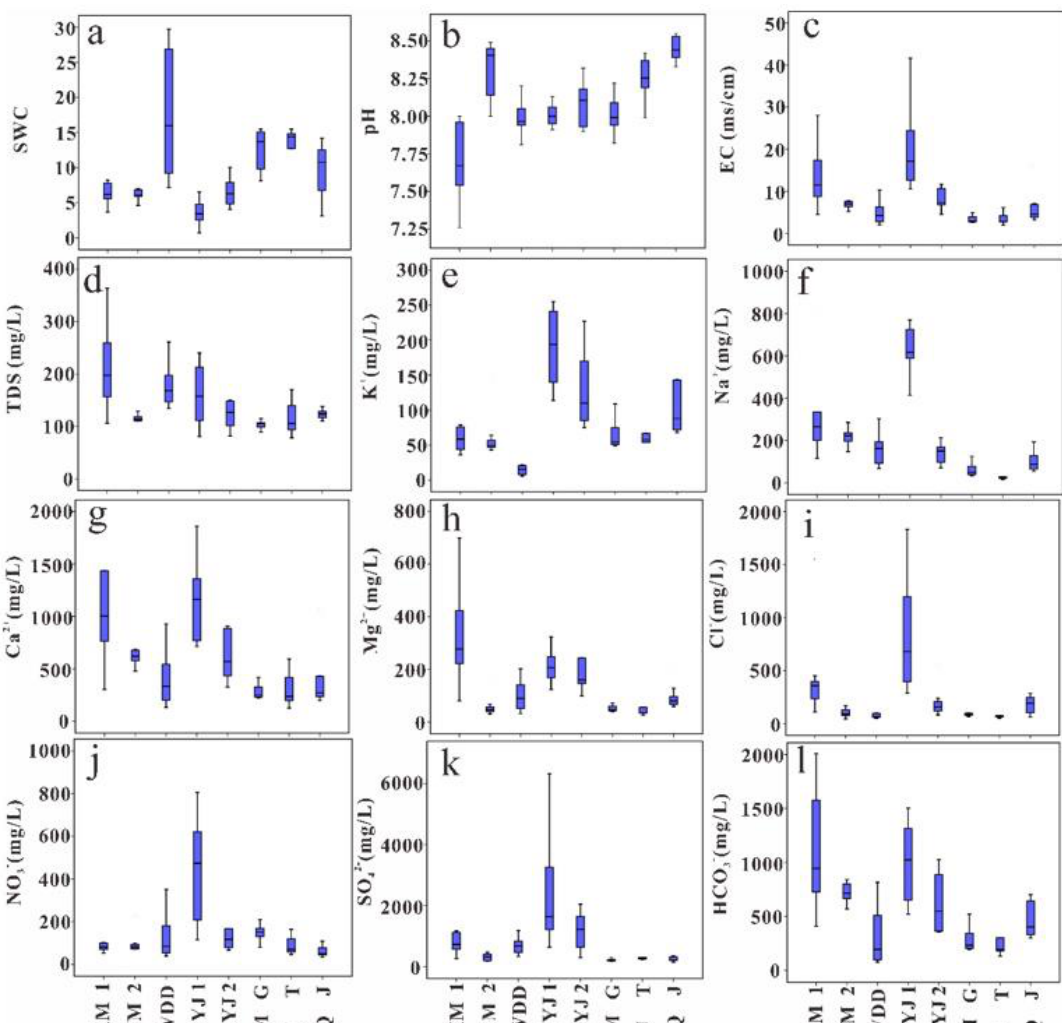
Figure 2. Boxplots for chemical composition of soil − soluble salt (a is for soil water content, b is for pH, c is for EC, d is for TDS, and e to l are for K + , Na + , Ca 2+ , Mg 2+ , Cl − , NO 3 − , SO 42- , and HCO 3 − , re- spectively).